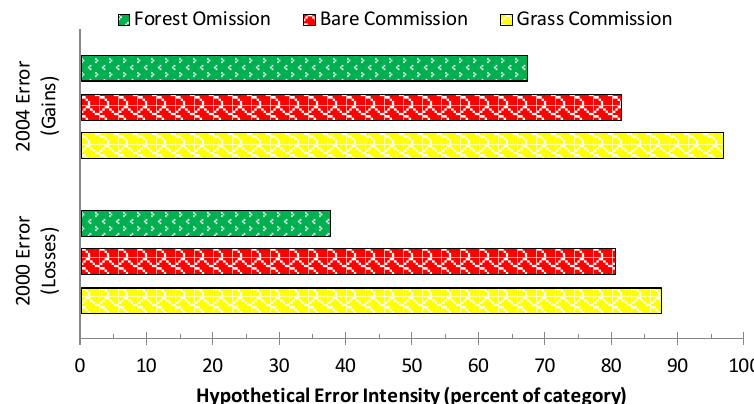
Figure 8. Hypothetical error intensities within the change region that could account for deviations from uniform category level losses and gains. If the actual error intensities are less than the ones in the figure, then there is evidence that the category level gains and losses are